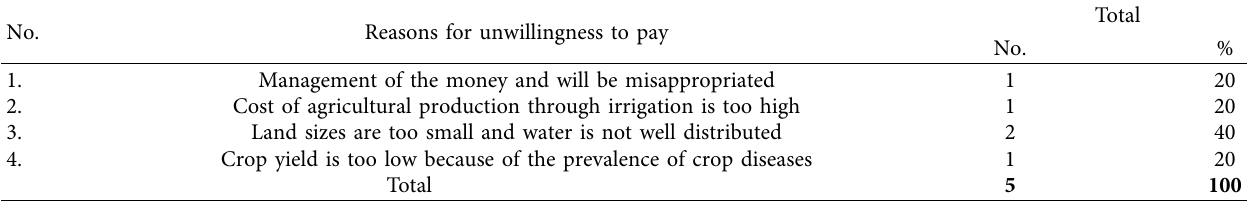
Table 4: Number of zero willingness-to-pay bids with reasons.